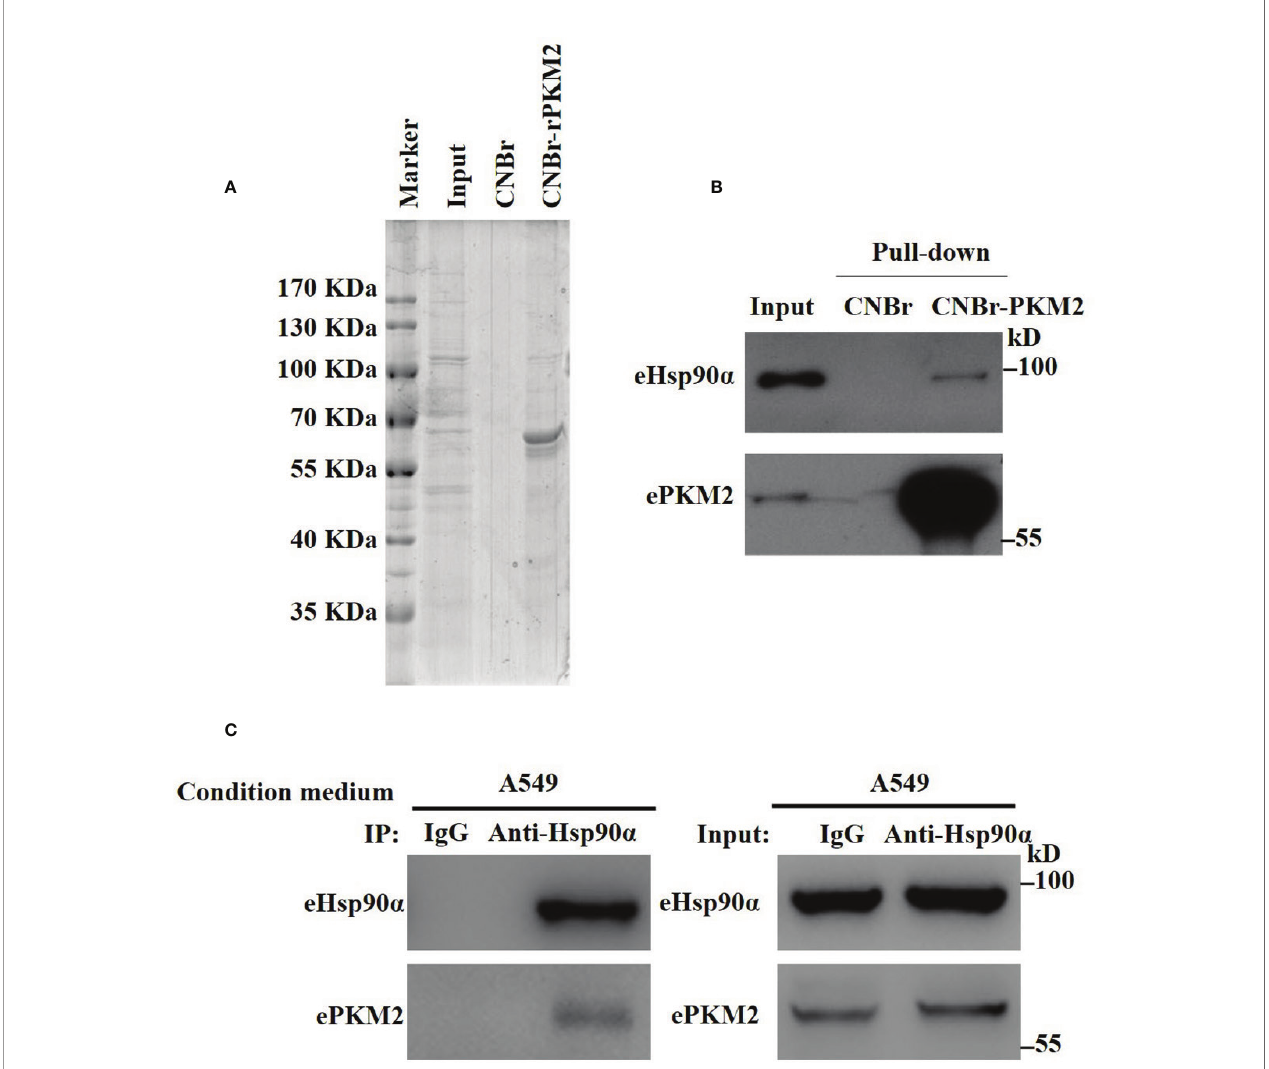
FIGURE 1 | Identi fi cation of eHsp90 a as an extracellular interacting protein of PKM2. (A) Eluted fraction of CNBr or CNBr-rPKM2 af fi nity chromatography was applied to SDS-PAGE before mass spectrometry analysis. (B) Pull-down assay showing the interaction between extracellular PKM2 and Hsp90 a in A549-conditioned media. (C) A549-conditioned media was collected and immunoprecipitated with IgG or anti-Hsp90 a antibodies. The immunoprecipitated samples were subjected to WB analysis with the indicated antibodies to detect the interaction between extracellular PKM2 and Hsp90 a